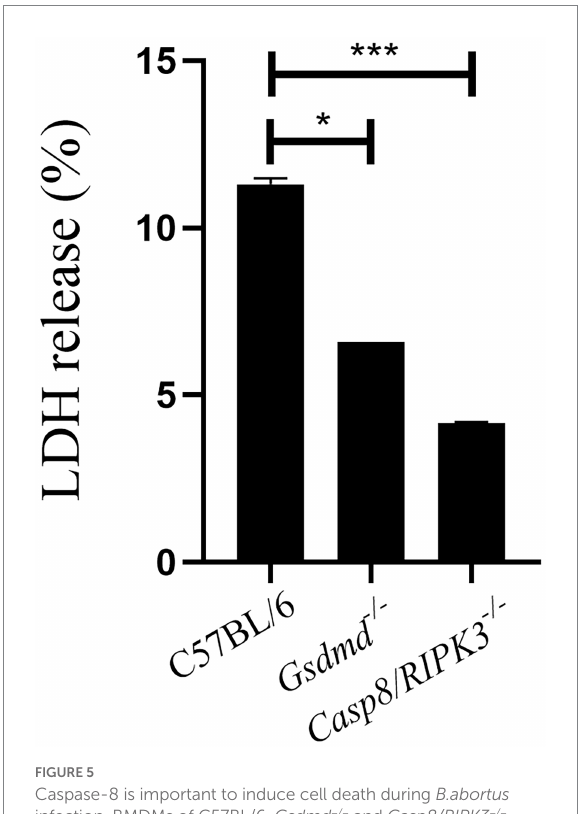
FIGURE 5 Caspase-8 is important to induce cell death during B.abortus infection. BMDMs of C57BL/6, Gsdmd − / − and Casp8/RIPK3 − / − were infected with B. abortus with MOI 100 for 8hs and LDH quantification was performed in the cell supernatant. Values represent the percentage of LDH released compared to control cells lysed with Triton X-100. Data show the mean ± the representative standard deviation of triplicates. The data are representative of three independent experiments. Student t -test, * p < 0.05, *** p < 0.001 compared to C57BL/6.